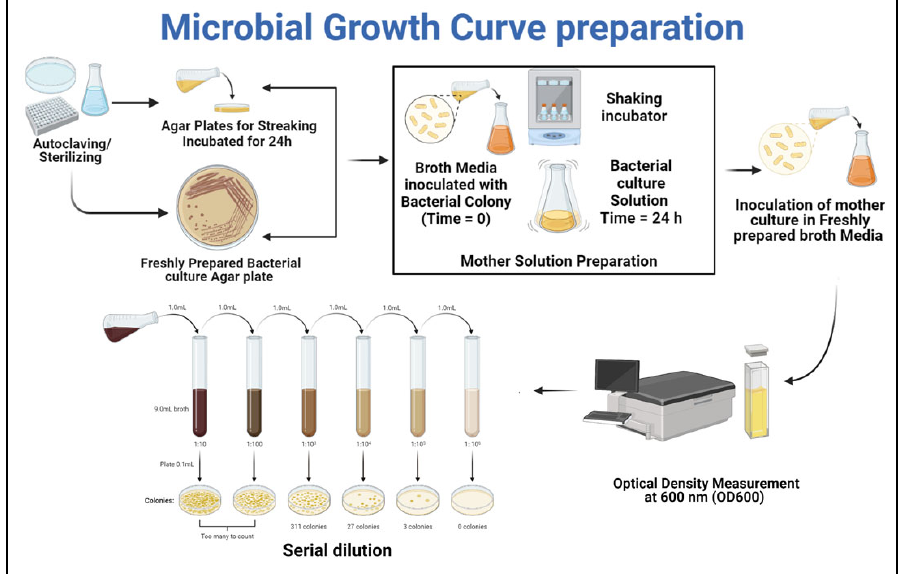
Figure 1 . Microbial life ‐ cycle assessment . Figure 1. Microbial life-cycle